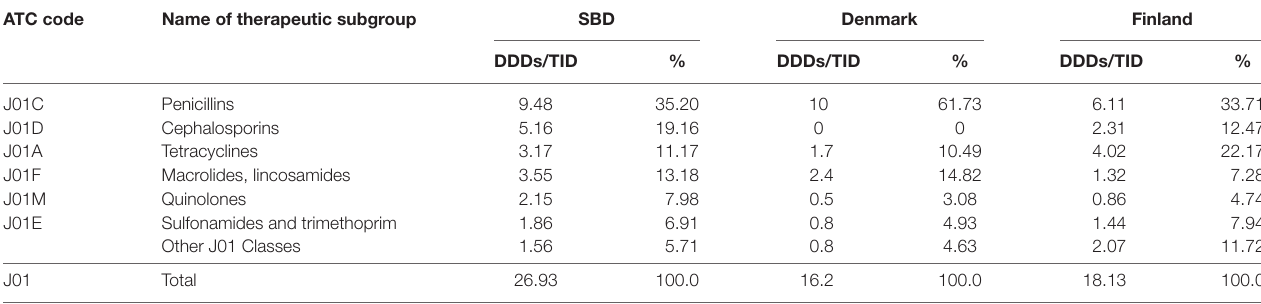
TaBle 1 | Total outpatient use of antibacterials for systemic use (J01) in South Backa District (SBD), Denmark, and Finland in 2008, expressed in defined daily doses per 1,000 inhabitants per day (DDDs/TID) and percentages. aTc